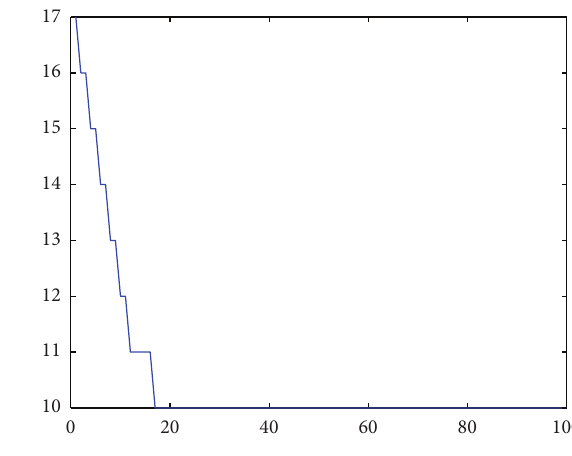
Figure 9: System input trajectory.